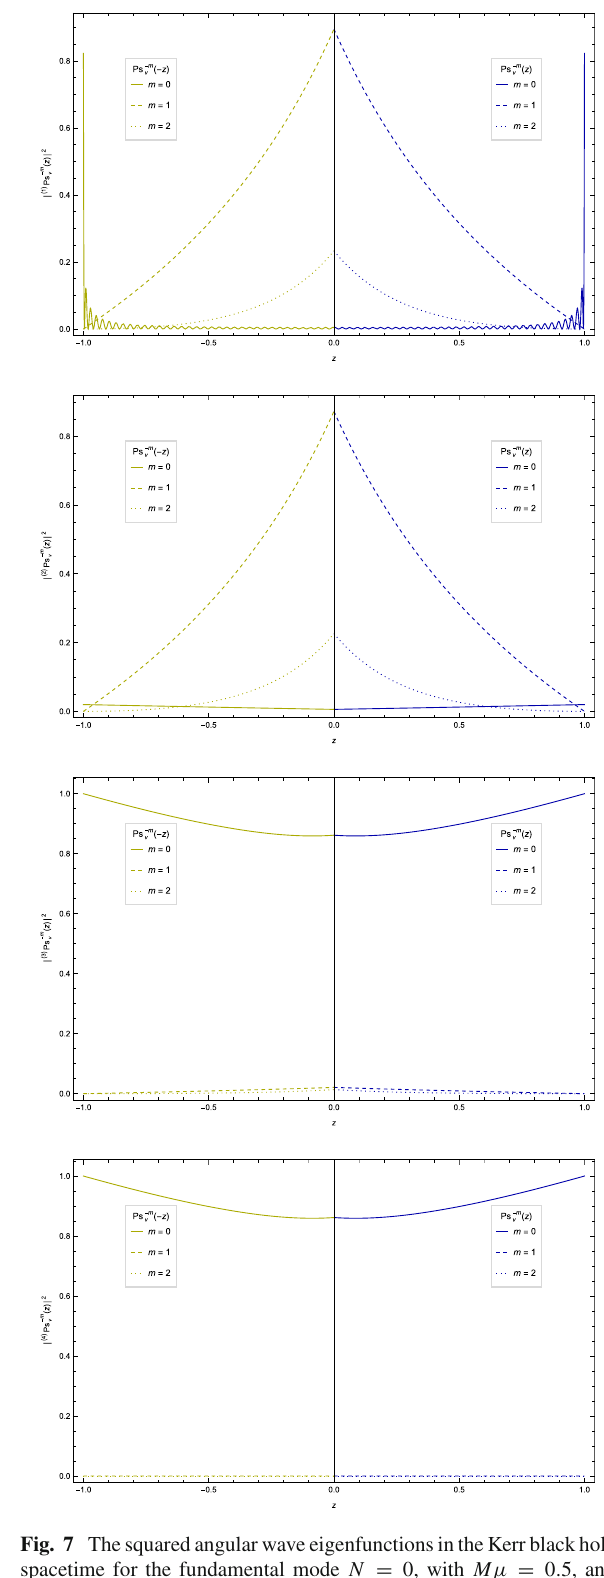
Fig. 7 The squared angular wave eigenfunctions in the Kerr blackhole spacetime for the fundamental mode N = 0, with M μ = 0 . 5, and a = 0 . 01, where z = cos θ . The units are in multiples of ( j ) C − m